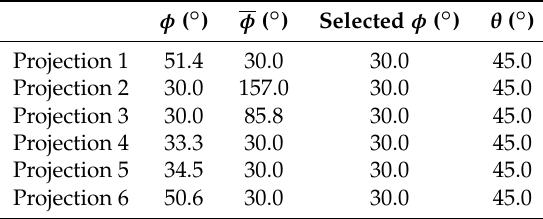
Table 2. Two possible solutions for six different fiber projections of fibers with φ = 30 ◦ and θ = 45 ◦ . φ ( ◦ )